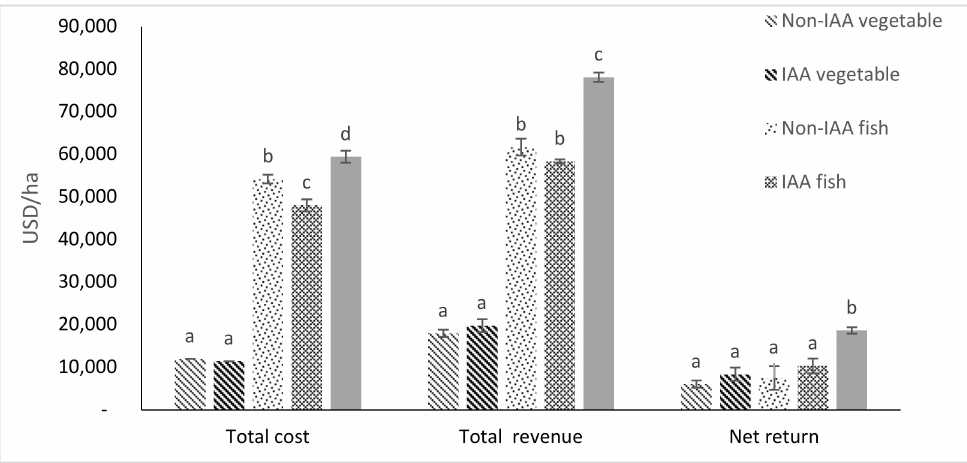
Figure 5. Economic analysis for fish and amaranths grown as separate systems or as an integrated system (within each group, bars with di ff erent letters are significantly di ff erent, p < 0.05). (Bars represent means ±